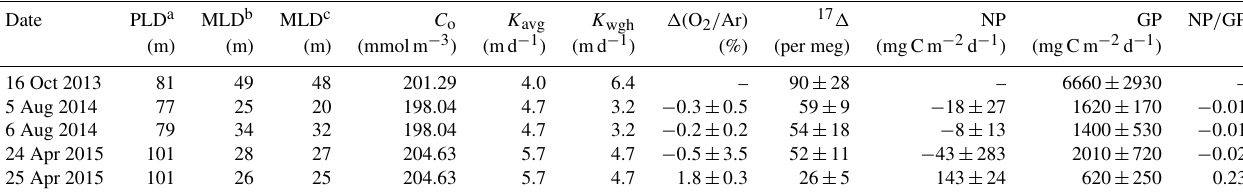
Table 1. Mixed-layer dissolved oxygen composition and estimated seasonal primary production rates at the SouthEast Asian Time-series Study (station 55, SEATS) in the South China Sea (SCS) for October 2013, August 2014 and April 2015. NP and GP were calculated using the O 2 -based mixed-layer depth and weighted gas exchange rate ( K wgh ). The GP and NP uncertainties are based on (cid:49) (O 2 / Ar), δ 17 O and δ 18 O variations between dissolved O 2 samples that were collected from a vertical profile through the mixed layer (1 σ of the mean, n = 3 for each sampling